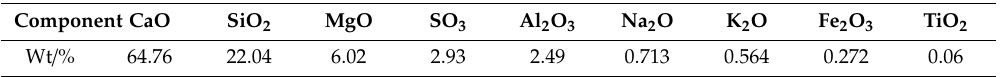
Table 1. Chemical compositions of P.W 52.5 cement.